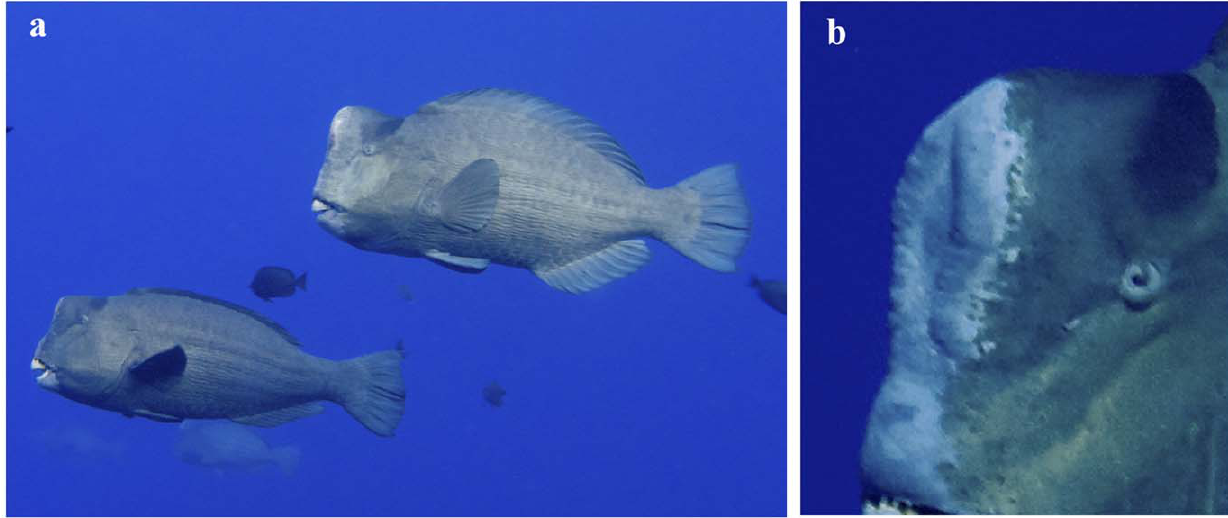
Figure 2. Sexual dimorphism in Bolbometoponmuricatum . ( a ) Female Bolbometopon (lower fish) and male (upper), illustrating dimorphic forehead profile which slopes caudal to beak in females but is nearly parallel with beak in males. Males are also typically larger than females [8]. All observations of courtship and spawning that we observed were between dimorphic fish, suggesting that sex can be determined in the field based on a combination of morphology and behavior [37,38]. This assumes that most female fish interacting with morphological and behavioral males are indeed female (but see [8,37,39, Mun˜oz et al. in prep]). ( b ) Detail of male forehead showing ossified ridge characteristic of large males. The ossified ridge and cephalic hump are reduced in